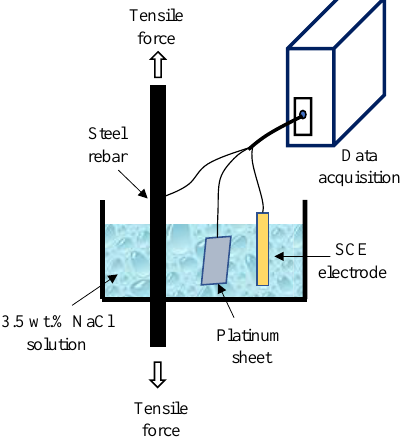
Figure 2. Schematic illustration of the stress-corrosion test set-up.